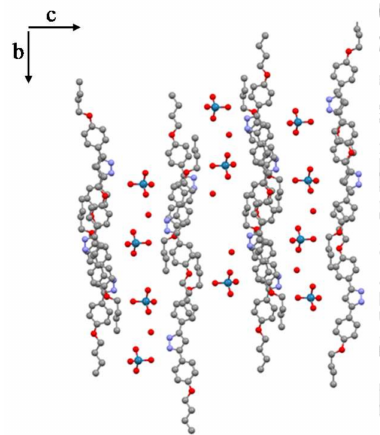
Figure 4. Layers in the bc plane showing chain interpenetration.